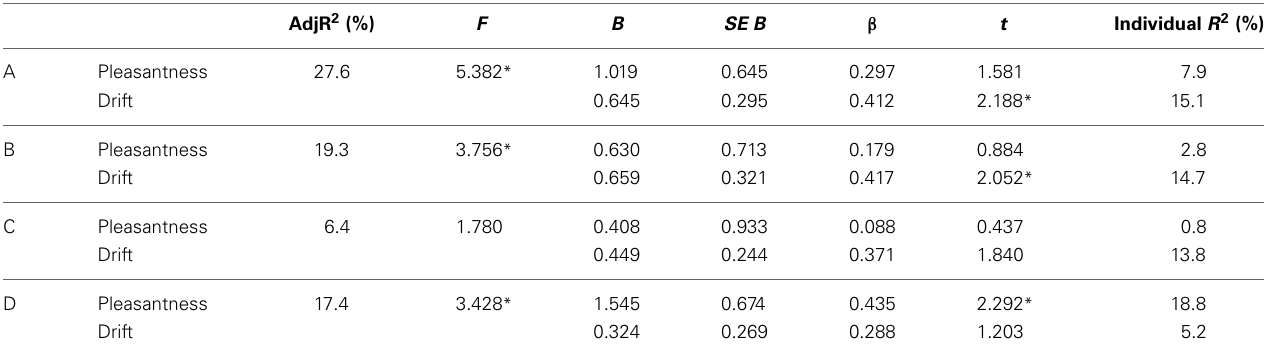
Table 4 | Regression statistics for all four experimental conditions with the dependent variable subjective scores on the questionnaire and independent variables pleasantness and